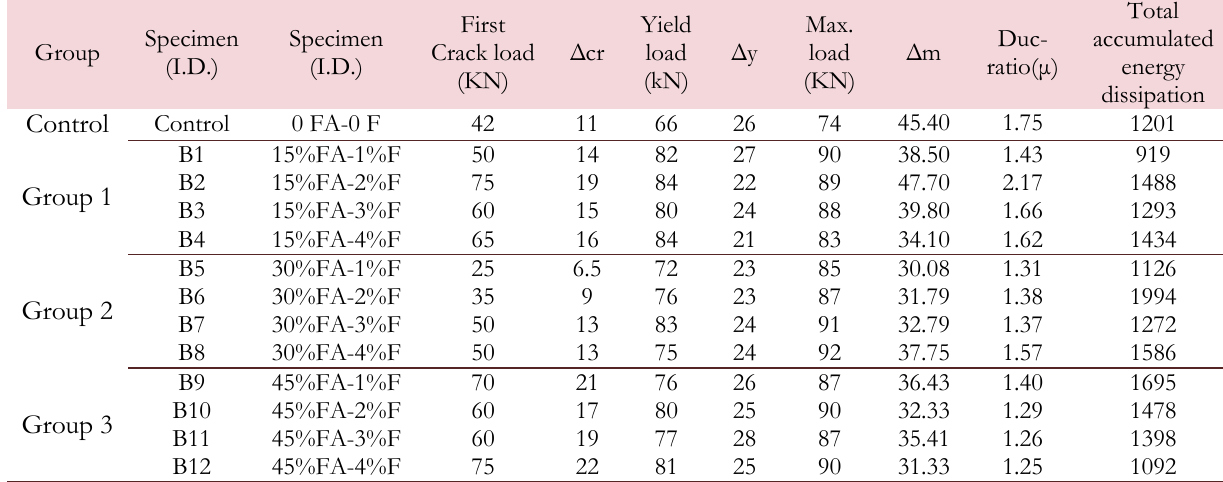
Table 4: Results of tested